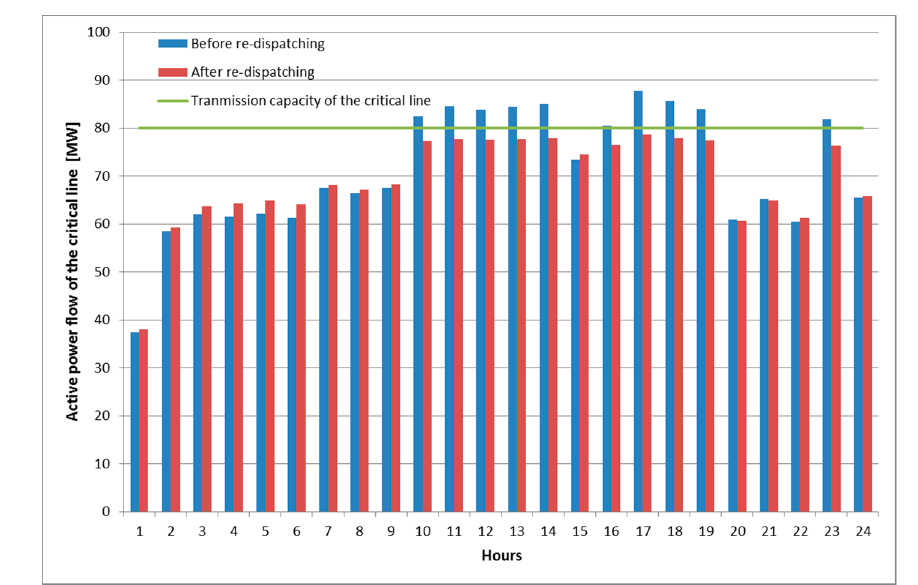
Figure 14. Comparison of the water volume in the reservoirs.